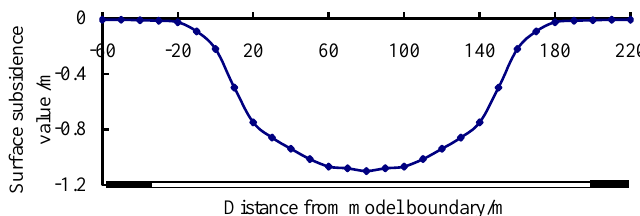
Figure 11. Surface subsidence curve of No. 1–2 seam mining.